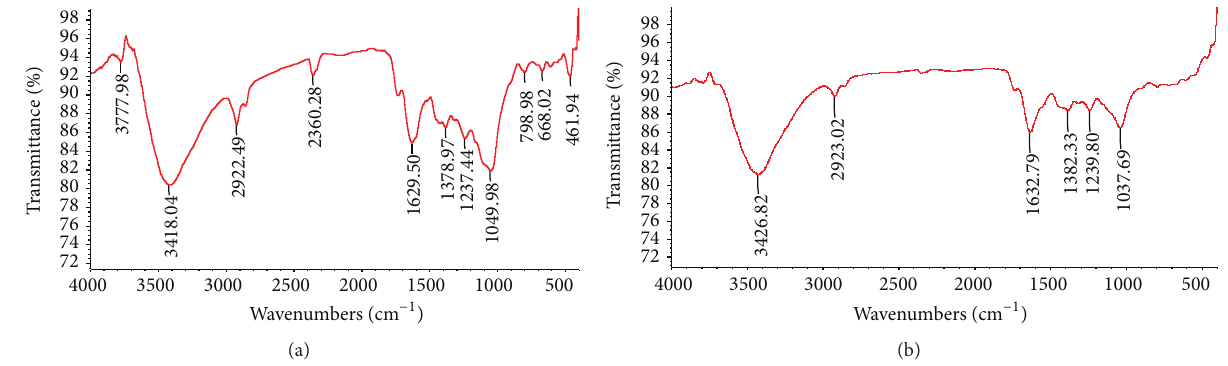
Figure 3: (a) FTIR spectra of Fe treated rice husk before adsorption. (b) FTIR spectra of Fe treated rice husk after simultaneous adsorption of Cr(VI) and phenol.